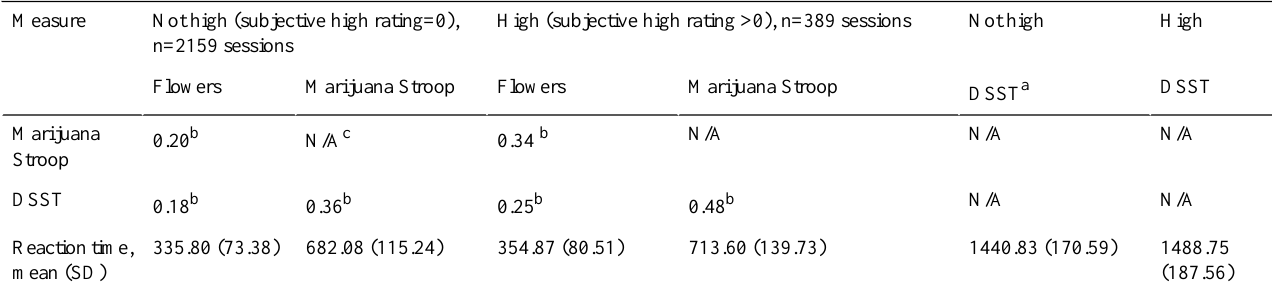
Table 1. Pearson correlations (r) and mean reaction time (millisecond) for 3 cognitive tasks (correlations do not take clustering of cases within individuals over time into